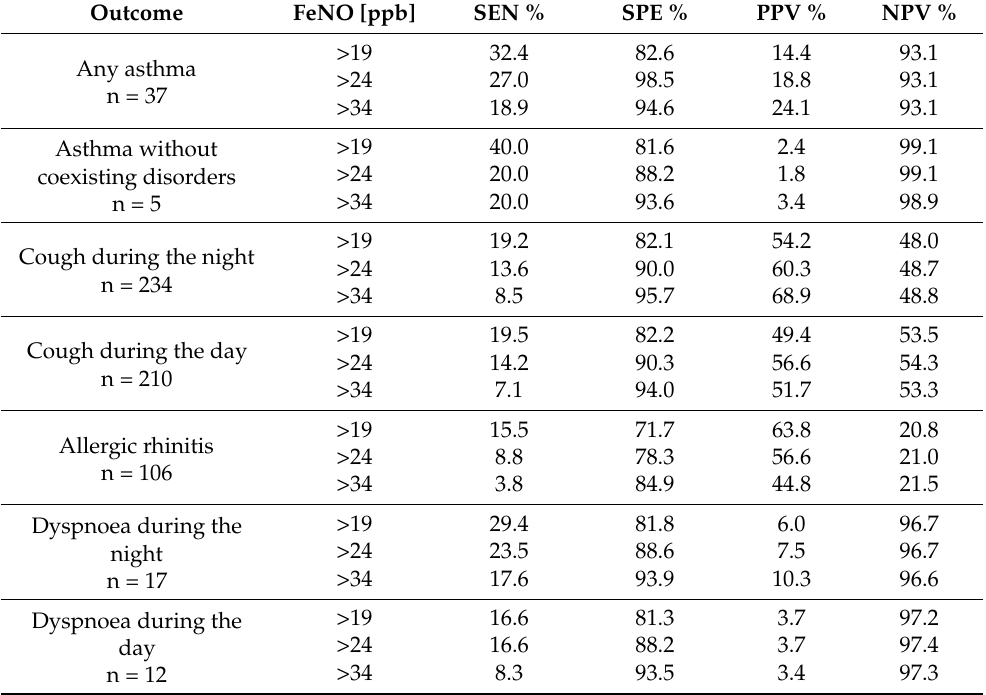
Table 1. Diagnostic accuracy (sensitivity, specificity, positive and negative predictive value) of FeNO in detecting treated asthma, allergic rhinitis, cough at night and day, dyspnoea at night and day in children vs. children without any respiratory